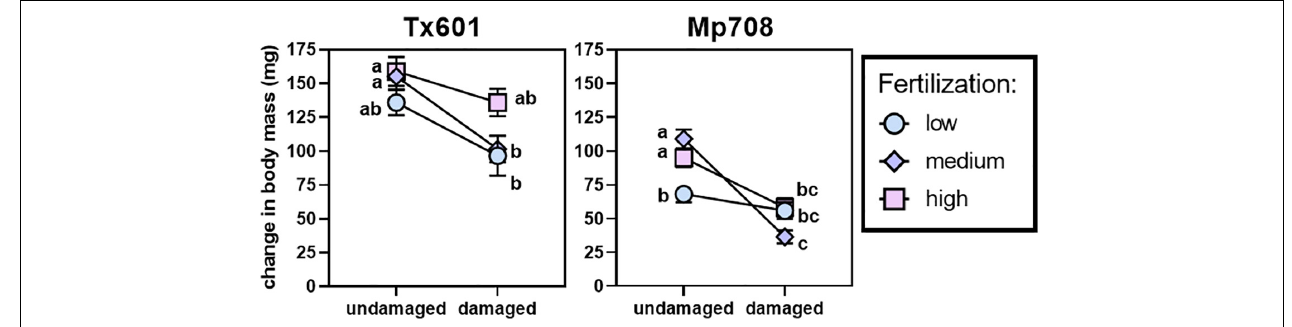
FIGURE 1 | Norm-reactive plot illustrating impacts of maize genotype, herbivory, and fertilization regime on fall armyworm growth. Symbols represent means with bars representing standard errors. Lines connect undamaged and damaged treatments. Different letters represent statistically significant responses within a genotype using a Holm correction ( p < 0.05). Data were analyzed using final mass as response variable in an ANCOVA, and full statistics are present in Table 2 .